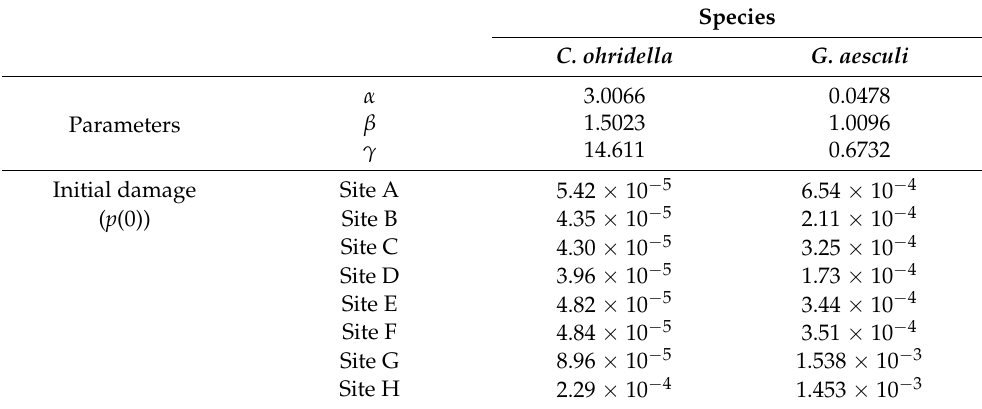
Table 3. Estimated parameter values and site-specific initial damages (proportions). α has dimension d − 1 , while β and γ are